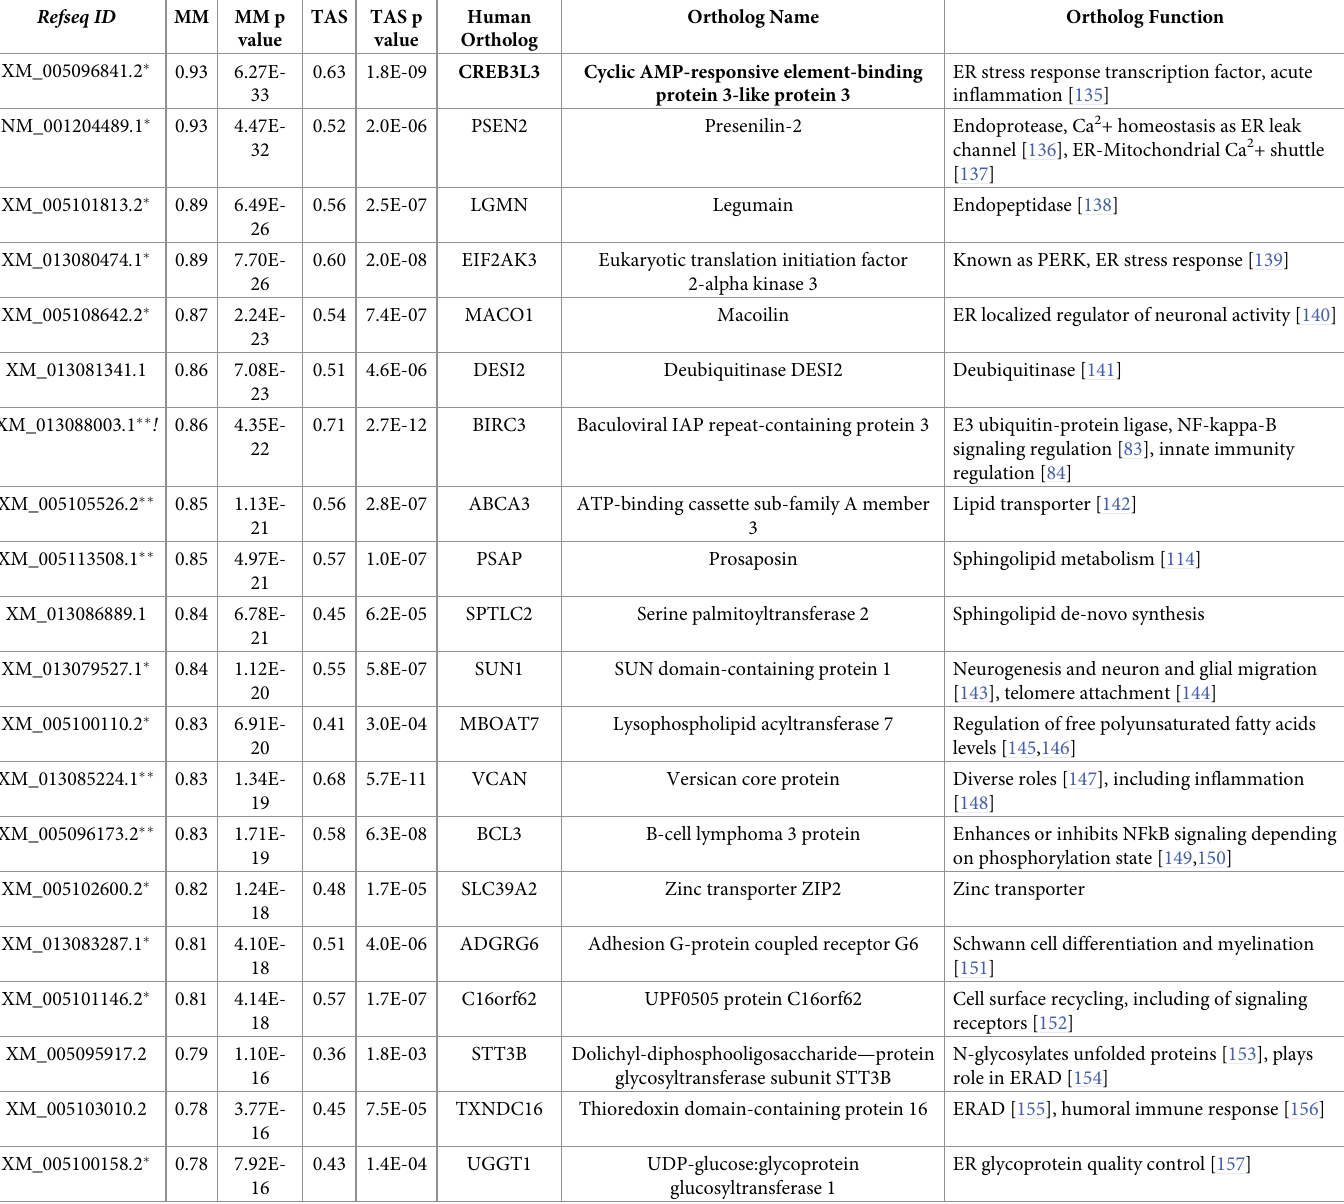
See Table 2 for description of organization. Common functions include Endoplasmic Reticulum (ER) stress response, ER associated protein degradation (ERAD), sphingolipid metabolism, and immune regulation. This module was positively correlated with age, suggesting these process are upregulated in